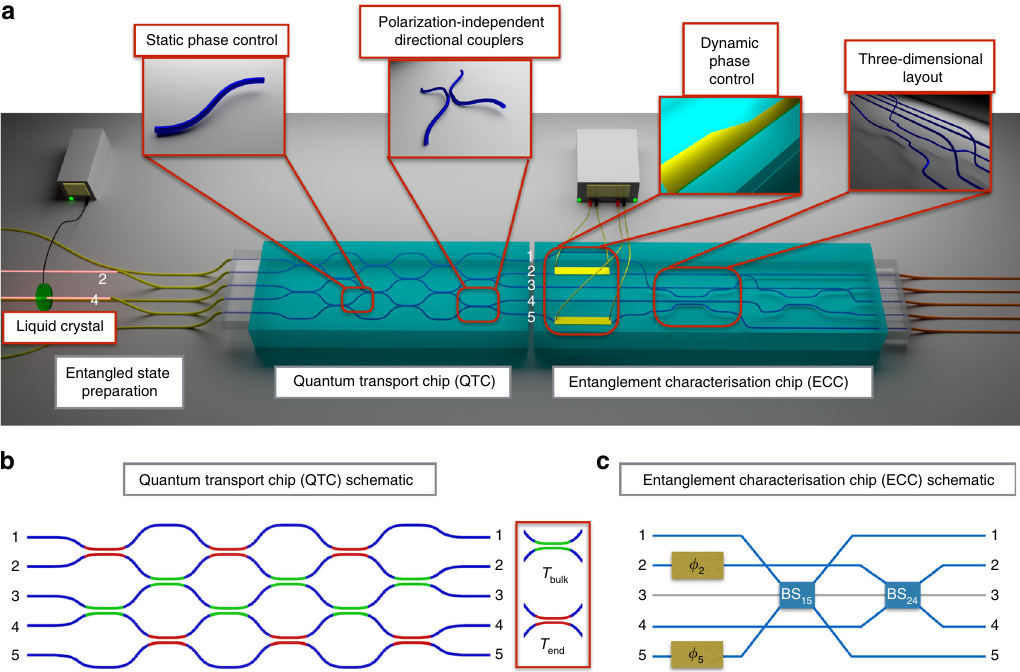
Fig. 2 Experimental layout. a Representation of the experimental apparatus comprised of the fi rst quantum transport chip and the second entanglement characterisation chip. The insets highlight the speci fi c elements and the three-dimensional geometry of the photonic devices. b Schematisation of the quantum transport device of the fi rst chip showing in green the directional couplers of the bulk (with transmissivity T bulk = 0.36) and in red those at the edge (with transmissivity T end = 0.25) of the device. c Schematic representation of the entanglement characterisation device of the second chip, showing the dynamic phase controls ϕ 2 and ϕ 5 acting on the 2nd and 5th waveguides and the 50/50 beam splitters between the (2, 4) and (1, 5) pairs of modes. The 3rd waveguide (in grey) is not involved in any interference processes